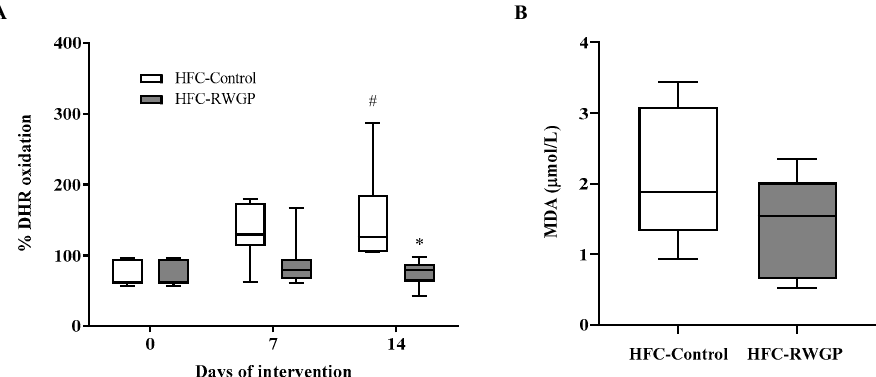
Figure 4. Effect of RWGP supplementation on high-density lipoprotein (HDL)-containing plasma antioxidant activity malondialdehyde (MDA) levels of SR-B1 KO / ApoER61 h / h mice fed with atherogenic diet. ( A ) % DHR oxidation at baseline and after 7 and 14 days of HFC diet. ( B ) Plasma MDA levels after 14 days of HFC diet intake. Data are shown in box plots (box, 25th to 75th percentiles; whiskers, median and IQR) ( n = 5–7). # p < 0.05 compared to day 0; * p < 0.05 vs. HFC-Control based on two-way